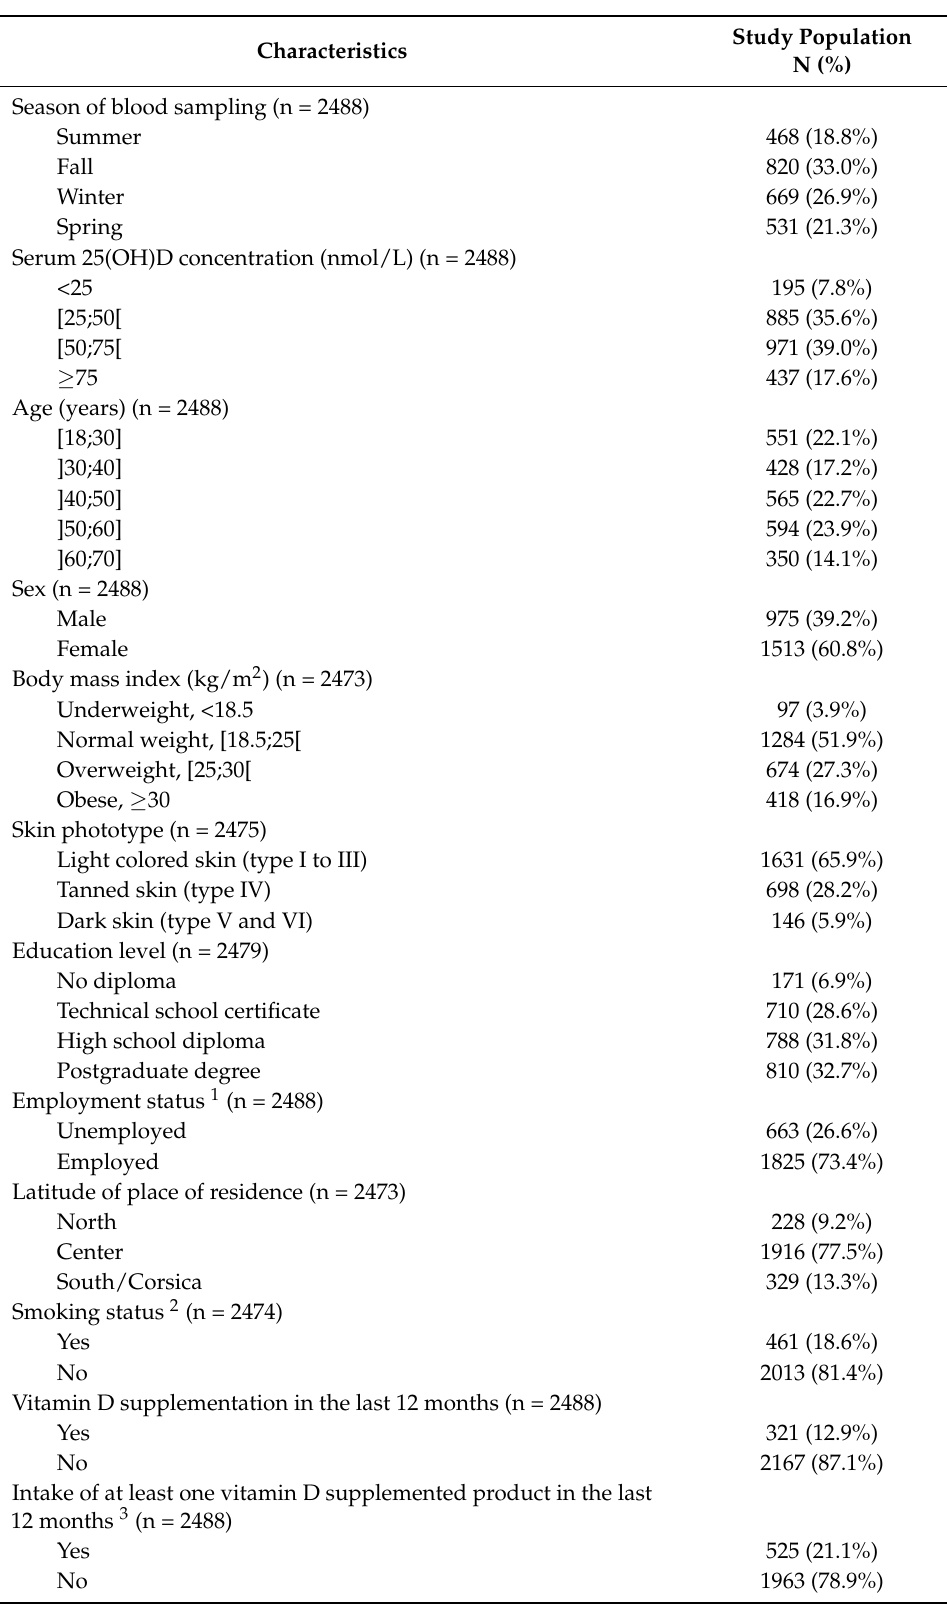
Table 1. Characteristics of the study population (n =